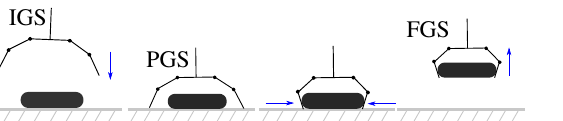
Figure 10. The concept of the grasp strategy for grasping the “pill box” from a table. The set of the produced IGSs place the palm frame { G } w.r.t. { O } with position = λ ˆ s = [ − ˆ u × ˆ s − ˆ s ] , where λ ∈ R is a small p O , n and orientation R OG O , n ˆ u O , n OG constant representing the distance of the palm from the support surface, ˆ s O , n the surface normal w.r.t. { O } and ˆ u is the normal vectors of the bounding box’s faces, which are